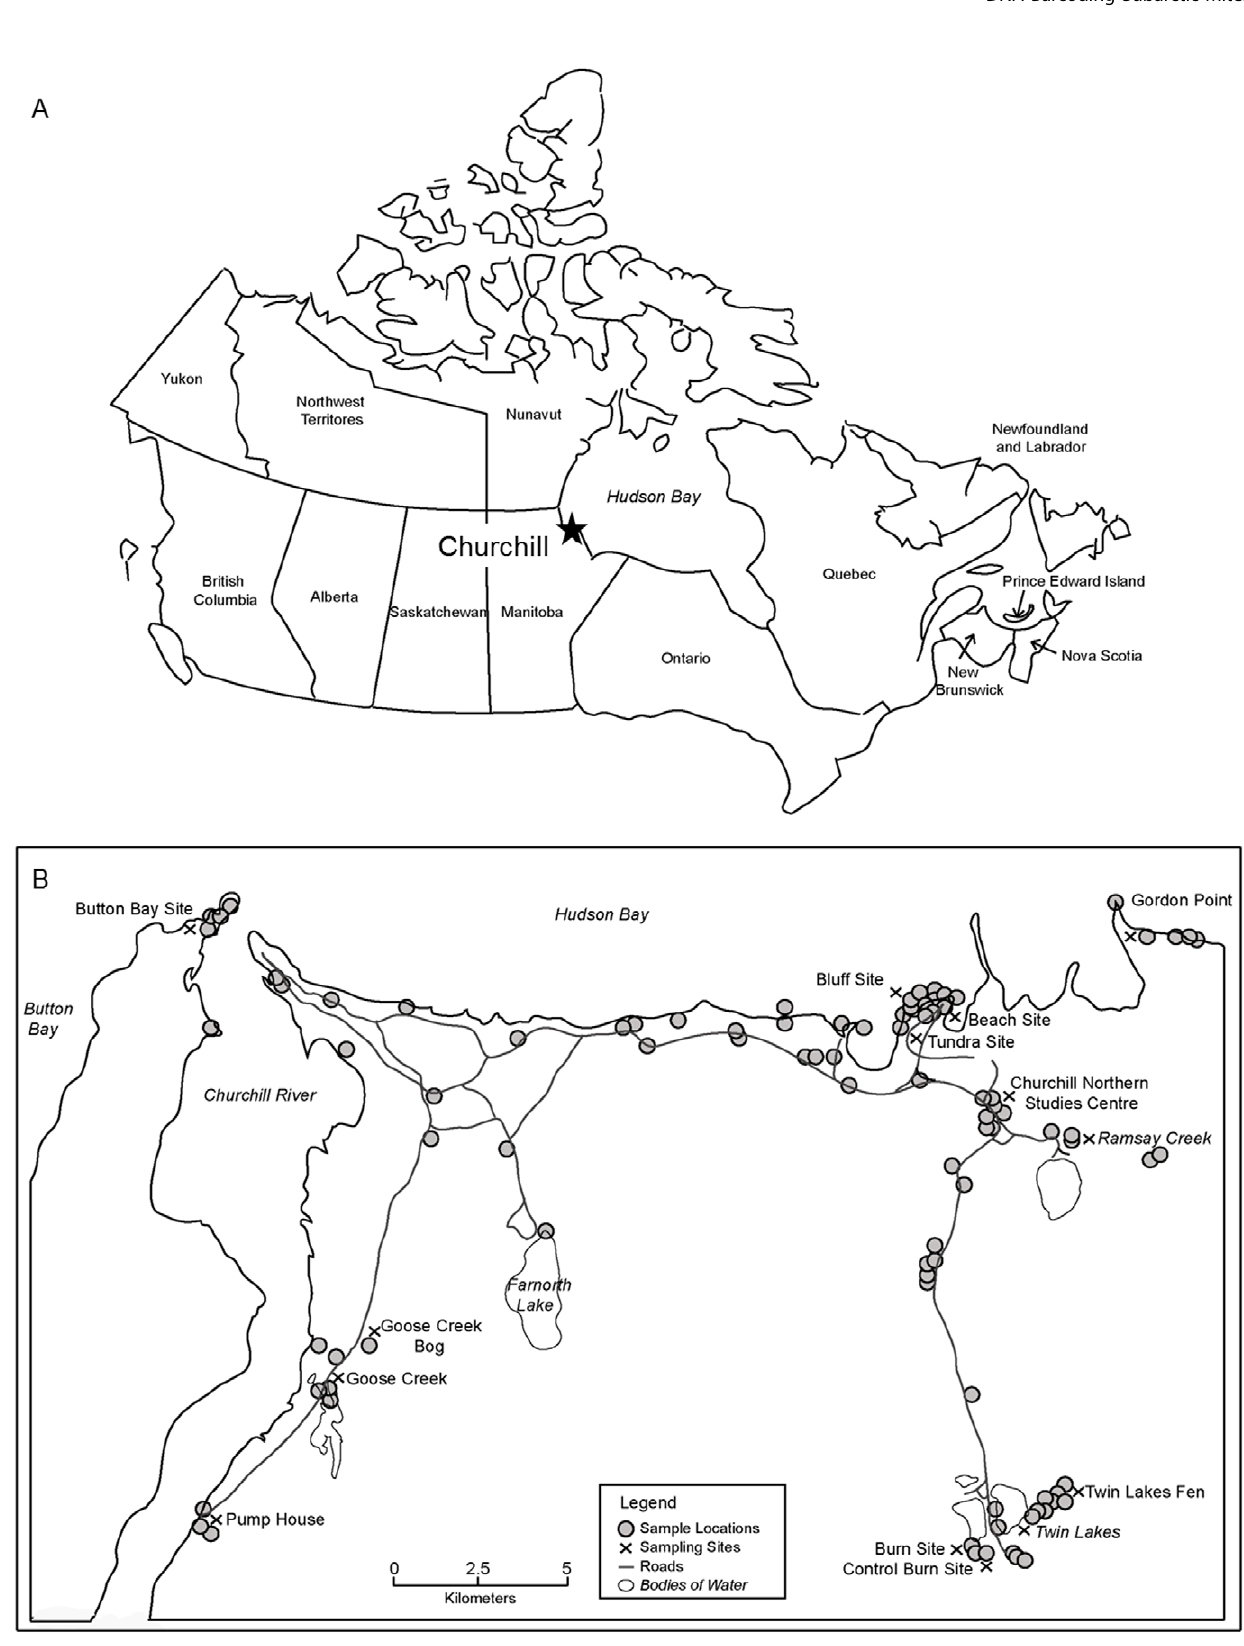
Figure 1. Sampling locations at Churchill. Maps depict a) the location of Churchill in Canada, and b) all sample locations along with specific sampling sites in the Churchill region.